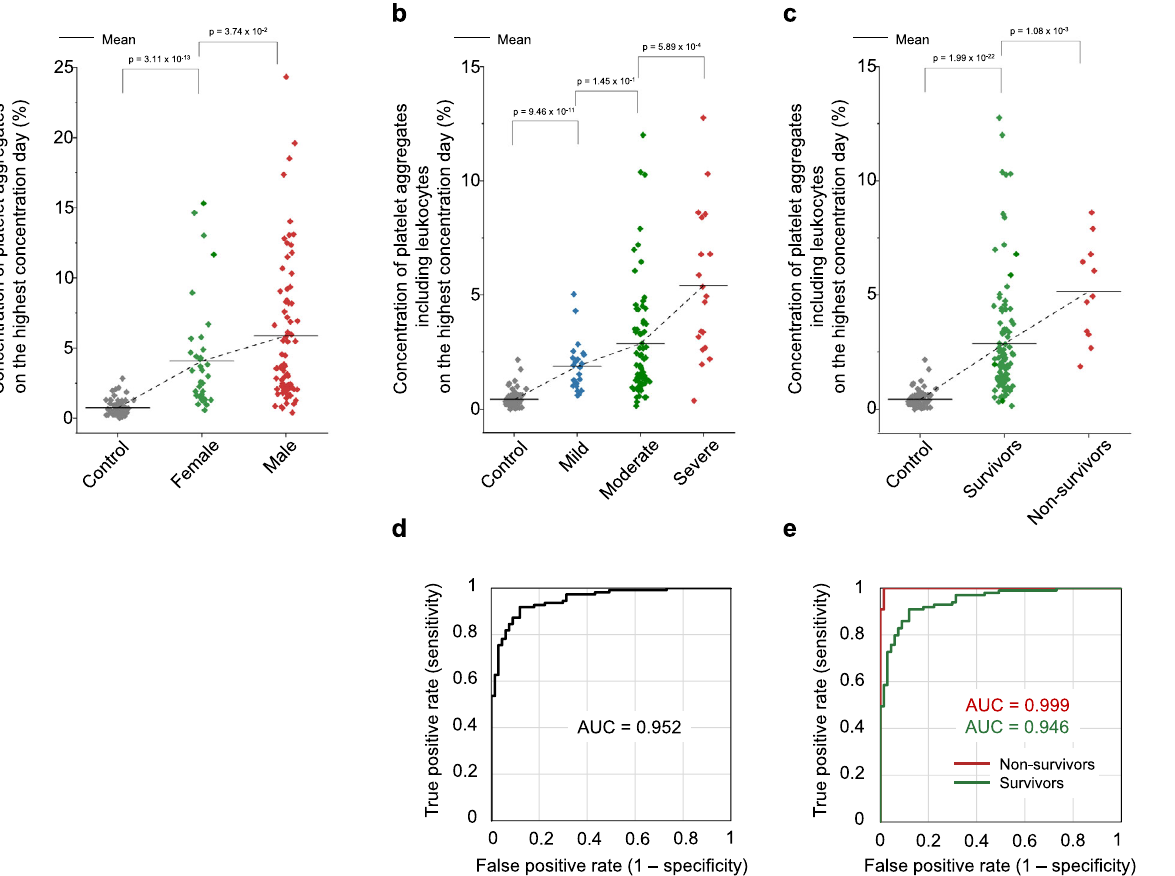
Fig. 4 In fl uence of sex differences and leukocytes. P values of every two adjacent classes were obtained using the Mann – Whitney U -test (two-sided) and shown in fi gures. a Comparison of the platelet aggregate concentrations of male ( n = 73) and female ( n = 37 biologically independent samples) patients, measured on the highest concentration day of each hospitalized patient. p = 8.97 × 10 -23 with the two-sided Kruskal – Wallis test. b Comparison of the concentrations of platelet aggregates of mild ( n = 23 biologically independent samples), moderate ( n = 68 biologically independent samples), and severe ( n = 19 biologically independent samples) patients with COVID-19 including leukocytes, measured on the highest concentration day of each hospitalized patient. p = 1.88 ×10 -23 with the two-sided Kruskal – Wallis test. c Comparison of the concentrations of platelet aggregates of survivors ( n = 99 biologically independent samples) and non-survivors ( n = 11 biologically independent samples) from COVID-19, measured on the highest concentration day of each hospitalized patient. p = 7.91 × 10 − 24 with the two-sided Kruskal – Wallis test. d , e ROC curves of the data shown in Fig. 4b, c, respectively. Source data